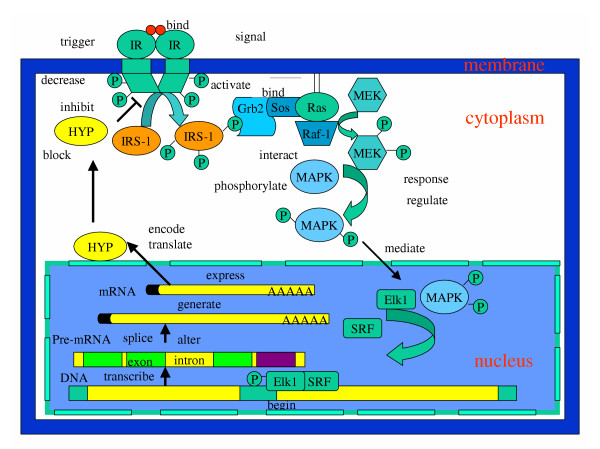
Molecular events shown by associated predicates. The figure shows a hypothetical signal transduction pathway of an idealized cell. The signal is triggered at the outer membrane ligand-binding to receptor dimers. This signal is mediated (by various proteins) to the nucleus of the cell using various events (protein-protein interactions, phosphorylation etc.) and initiates transcription of a gene. The protein product (after splicing, translation and synthesis) of the gene inhibits receptor signaling. Thus, it regulates its own expression levels via a negative feedback loop. The direction of information flow is shown with arrows. Cell compartments, molecular entities and predicates describing various events are shown. The predicates analyzed in this work aim to cover events in gene expression, regulation and signaling processes.